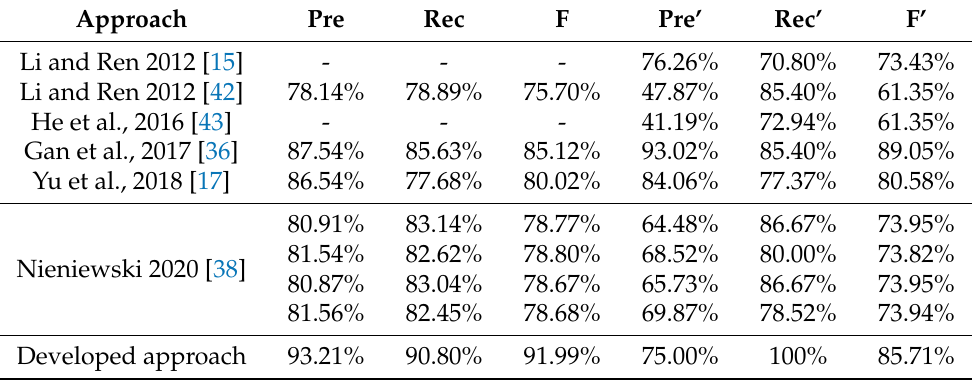
Table 7. Comparison with the literature (Type-I dataset). Pre, precision; Rec,